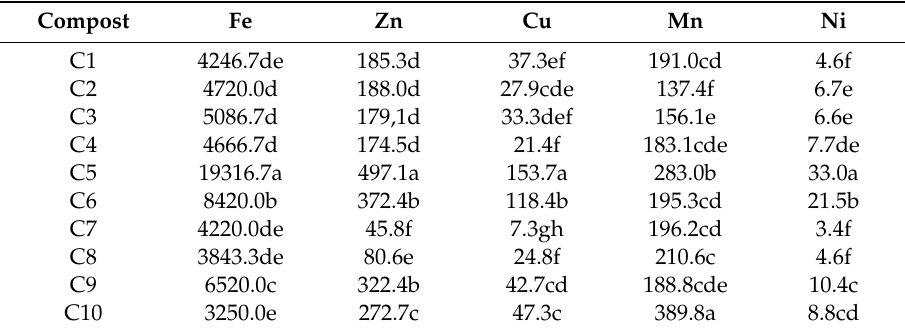
Table 4. Micronutrient contents in analysed composts (mg · kg − 1 ).